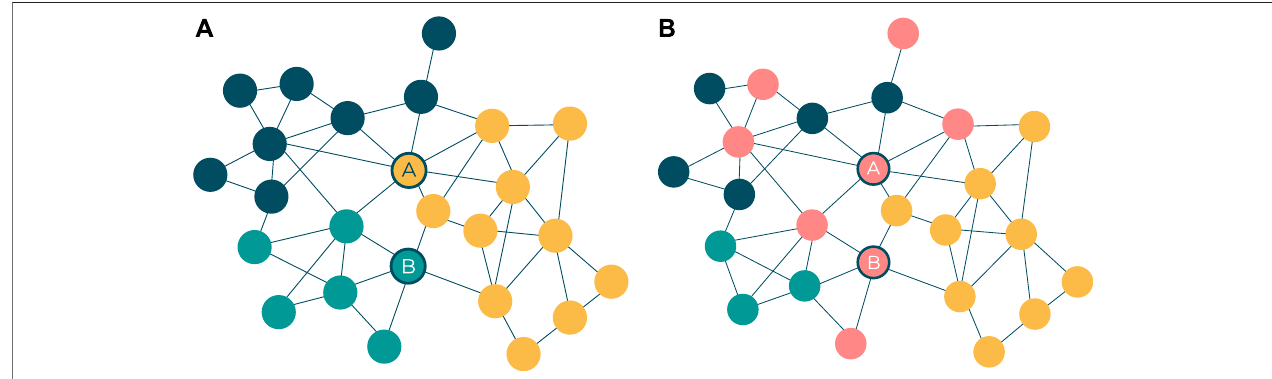
FIGURE 2 | (A) Pivotal proteins (represented by nodes A and B) are loosely de fi ned as proteins that facilitate cross-talk between network modules. This has some overlap with the notion of a node with high betweenness centrality (Freeman 1977), but there is emphasis on the node ’ s connectivity across network modules. Node A representsatargetbelongingtotheyellownetworkmoduleandinteractswiththehighestnumberoftargetsinthebluemodule.NodeBrepresentsatargetbelongingto thegreennetworkmoduleandinteractswiththehighestnumberoftargetsintheyellowmodule. (B) Pathwaymembership,representedbynodescoloredred,can be scattered across different network modules. While the modules in the network may represent distinct GO processes, biological pathways serve multiple such processes and are therefore seldom con fi ned to one